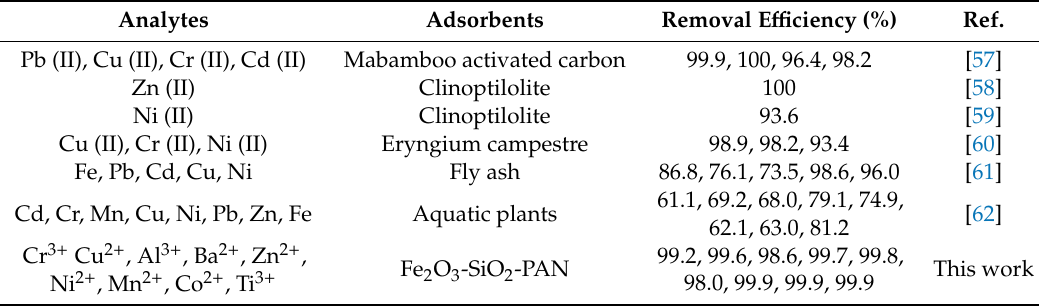
Table 7. Comparison of heavy metal removal using other